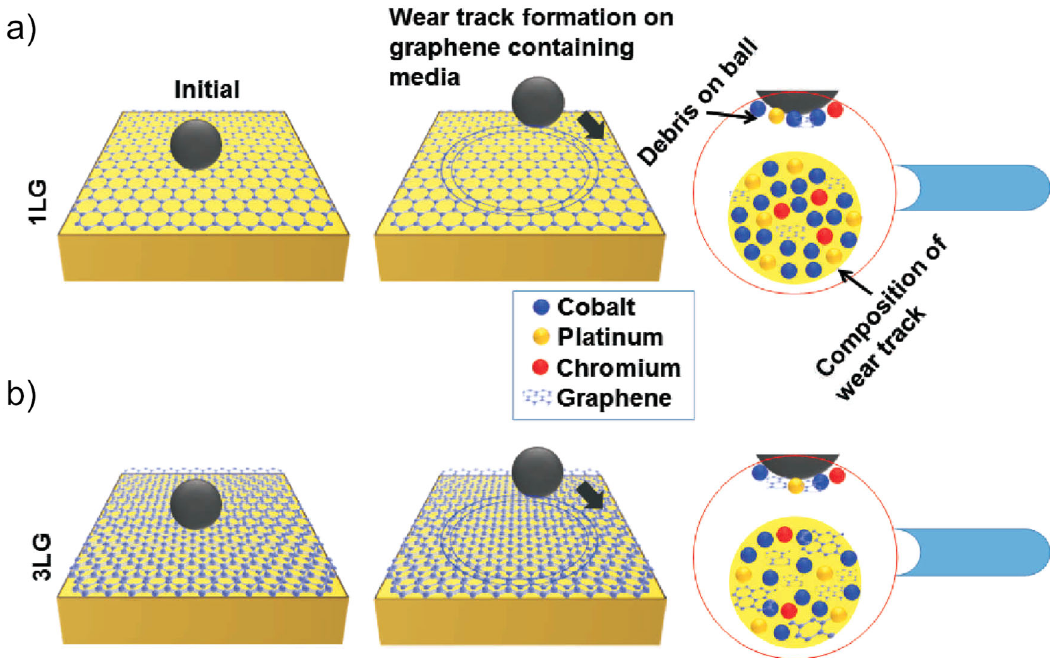
Fig. 9 Friction model. Interaction of counterface ball (sapphire) with ( a ) 1LG and ( b ) 3LG. The zoomed-in images represent 1LG and 3LG, and underlying substrate atoms (Co, Pt, Cr, etc.) on counterface ball and wear track, where the amount of C debris increases with N . The debris generated on both interacting bodies maintain the lower COF of 1 – 4LG with respect to